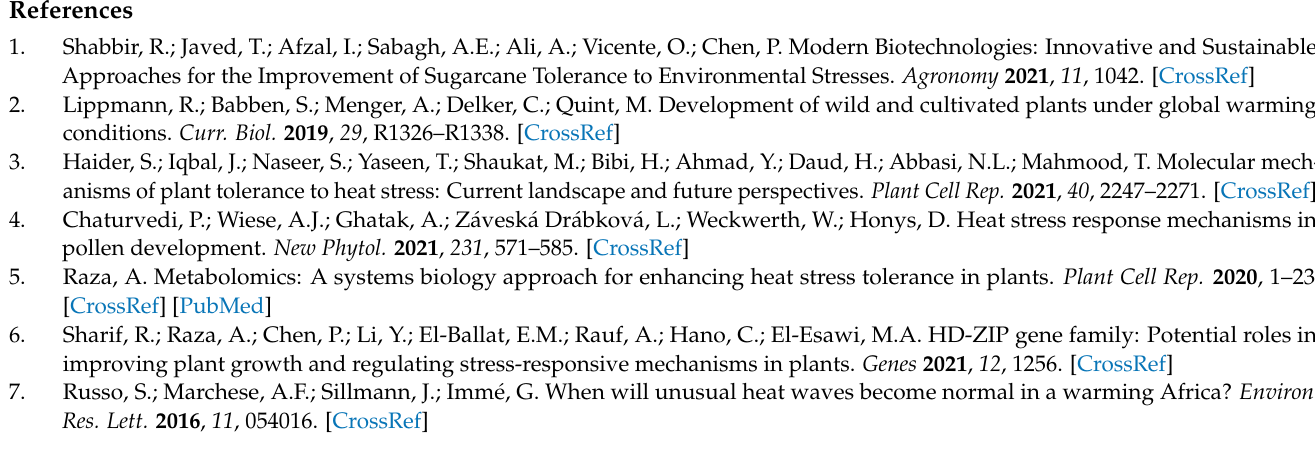
Table S3: The class specific amino acid composition of Zea mays HSFs; Table S4: FPKM values of Zea mays HSFs under different growth stages across various tissues; Table S5: FPKM values of Zea Table S7: Protein–protein interaction network file of Zea mays